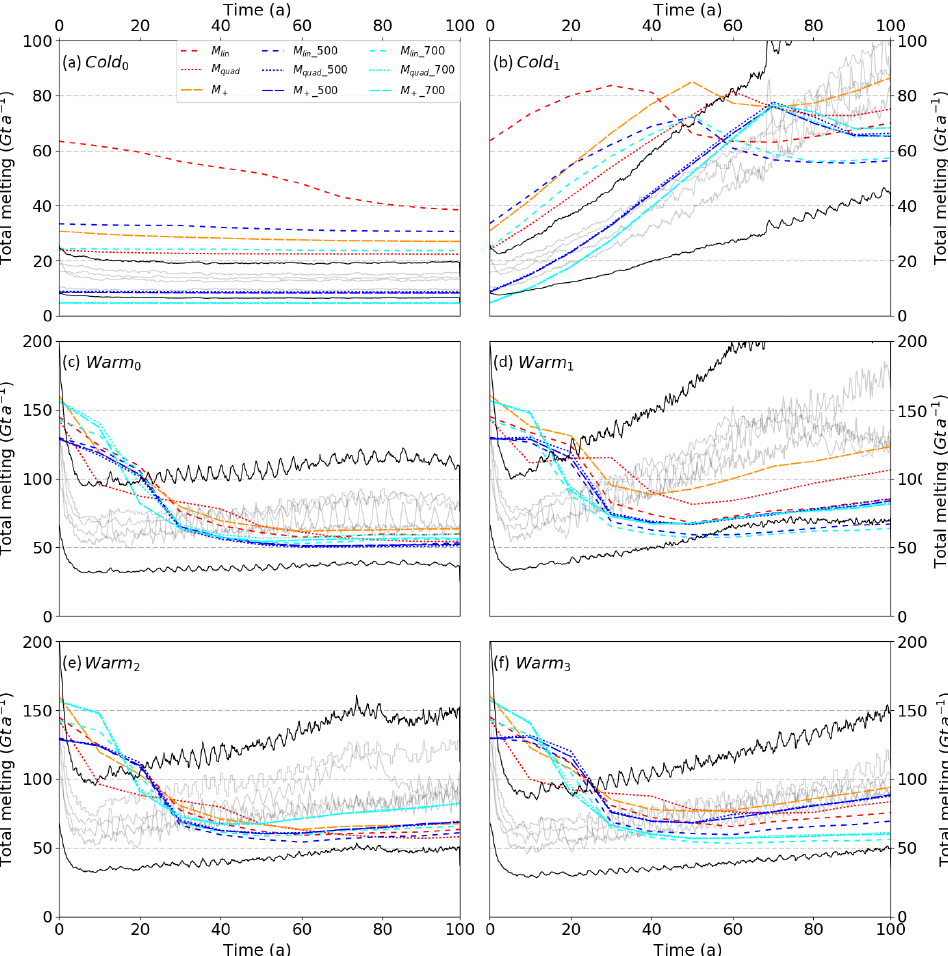
Figure 5. Total melt rates for simple parameterisations (Sect. 2.3.1). The coupled simulations are shown in solid light grey. The coloured lines correspond to parameterised simulations. The black solid lines correspond to a 50% underestimation or overestimation compared to the average of coupled runs